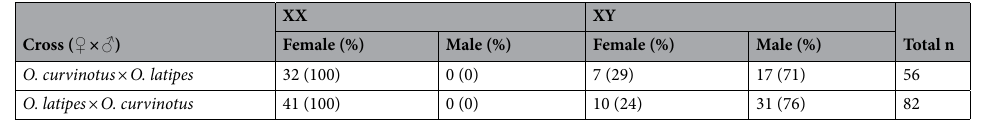
Table 1. Genotypic and phenotypic sexes of the hybrids from O. latipes (carbio strain) and O. curvinotus (F1 crossings).